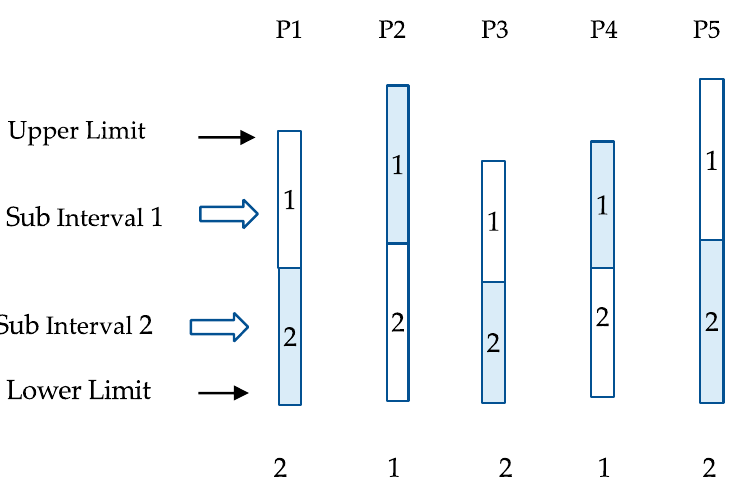
Figure 7. Band 2-1-2-1-2 of blocks from P1 to P5.